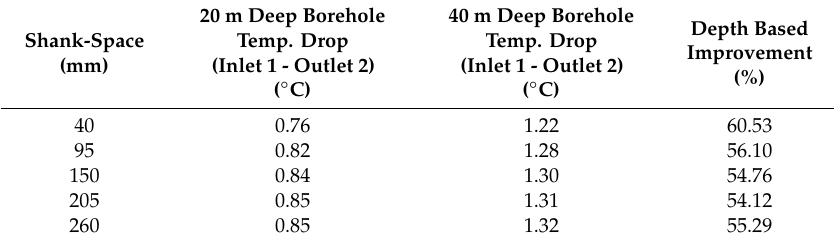
Table 4. Comparative depth-based improvement for the 20 m and the 40 m deep boreholes.